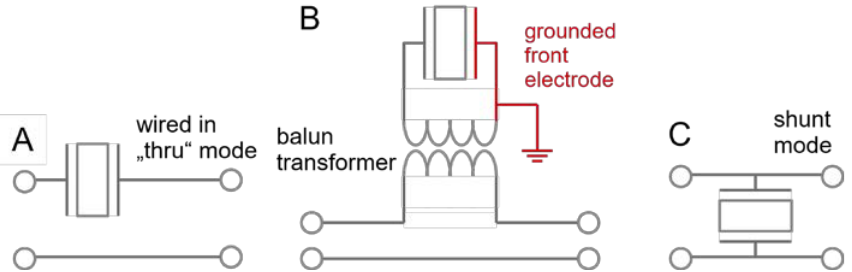
Figure 4. When working in liquids, wiring the resonator in the thru configuration ( A ) lowers the noise. A balun transformer (( B ), such as the unit ADT1-1 from Minicircuits) can be used to ground the front electrode. The shunt configuration ( C ) is not recommended for use in liquids.